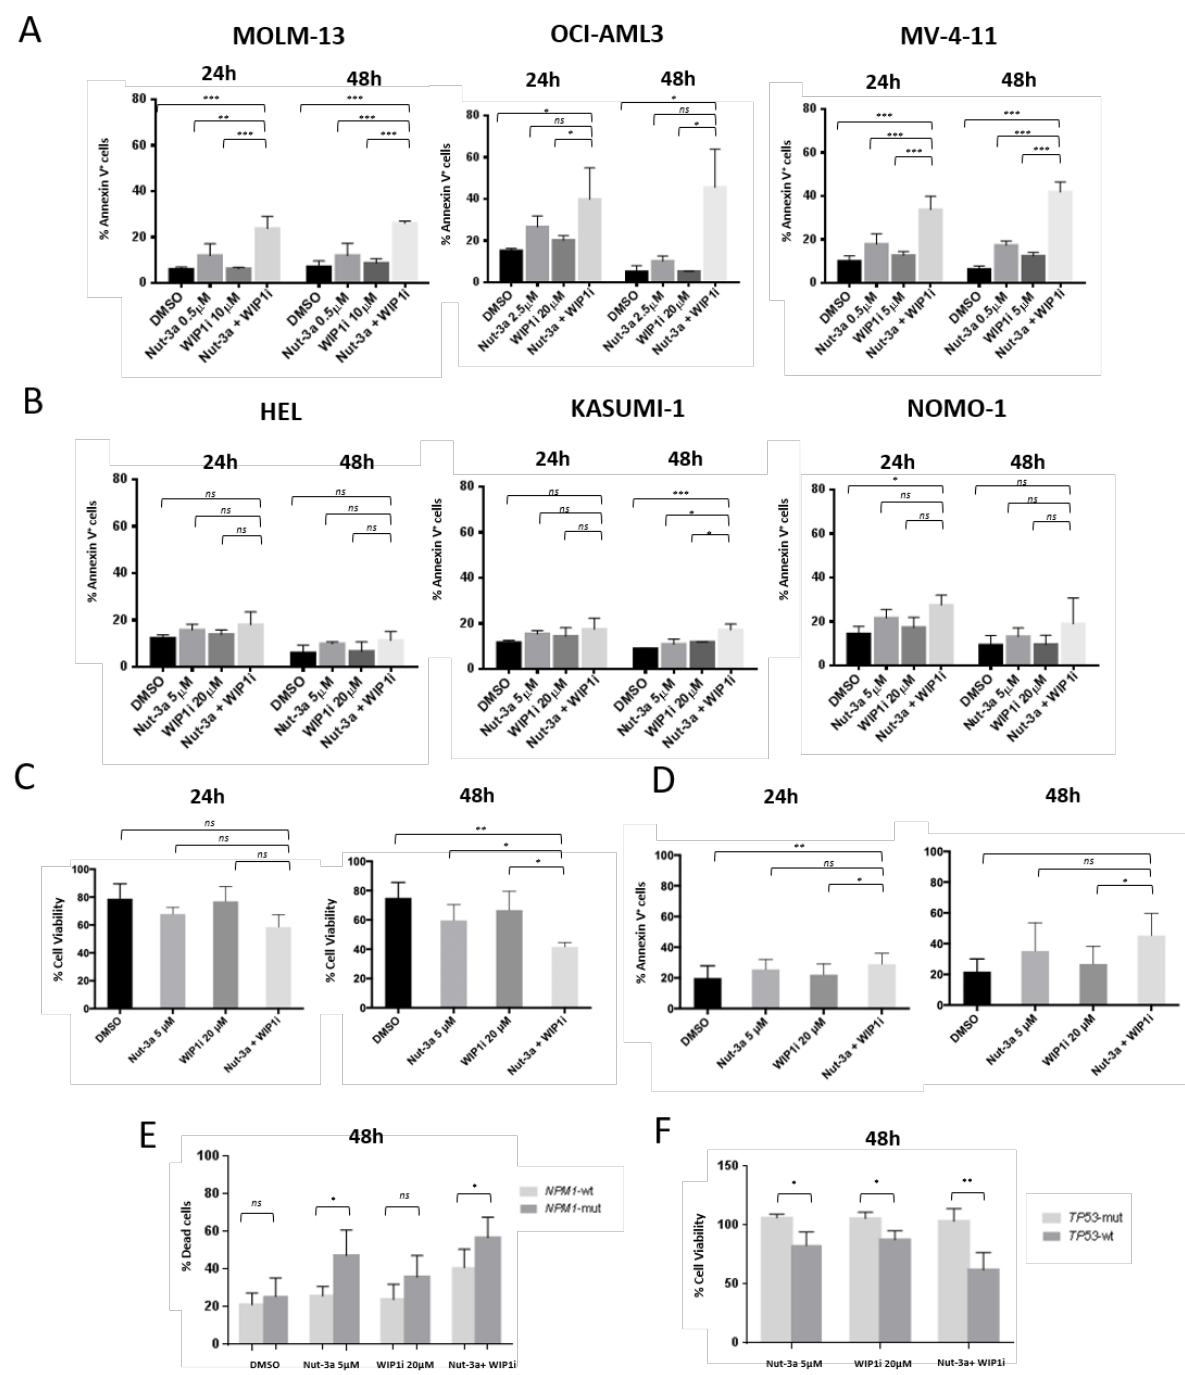
Figure 3. Apoptotic response of AML cell lines and primary cells to combined Nut-3a and WIP1i treatment. ( A ) Histograms showing the percentage of apoptotic (AnnexinV + cells) cells in TP53 -wt ( A ) and TP53 -mut cell lines ( B ) after 24 and 48 h treatment with single and combined Nut-3a and WIP1i. Average value and standard deviation of 3 independent experiments are shown. ( C ) Cell viability and ( D ) apoptotic response of TP53 -wt AML primary cells ( n = 3 and n = 6, respectively) after 24 h and 48 h treatment with single and combined Nut-3a and WIP1i treatments. ( E ) Histograms showing the percentage of dead cells in NPM1 -mut and NPM1 -wt primary AML cells ( n = 5 each) after 48 h treatment with single and combined Nut-3a and WIP1i. ( F ) Histograms showing the percentage of viable cells (normalized on vehicle-treated cells) in TP53 -mut ( n = 3) and TP53 -wt ( n = 4) primary AML cells after 48 h treatment with single and combined Nut-3a and WIP1i (* p < 0.05, ** p < 0.01, *** p < 0.001, ns: not significant).